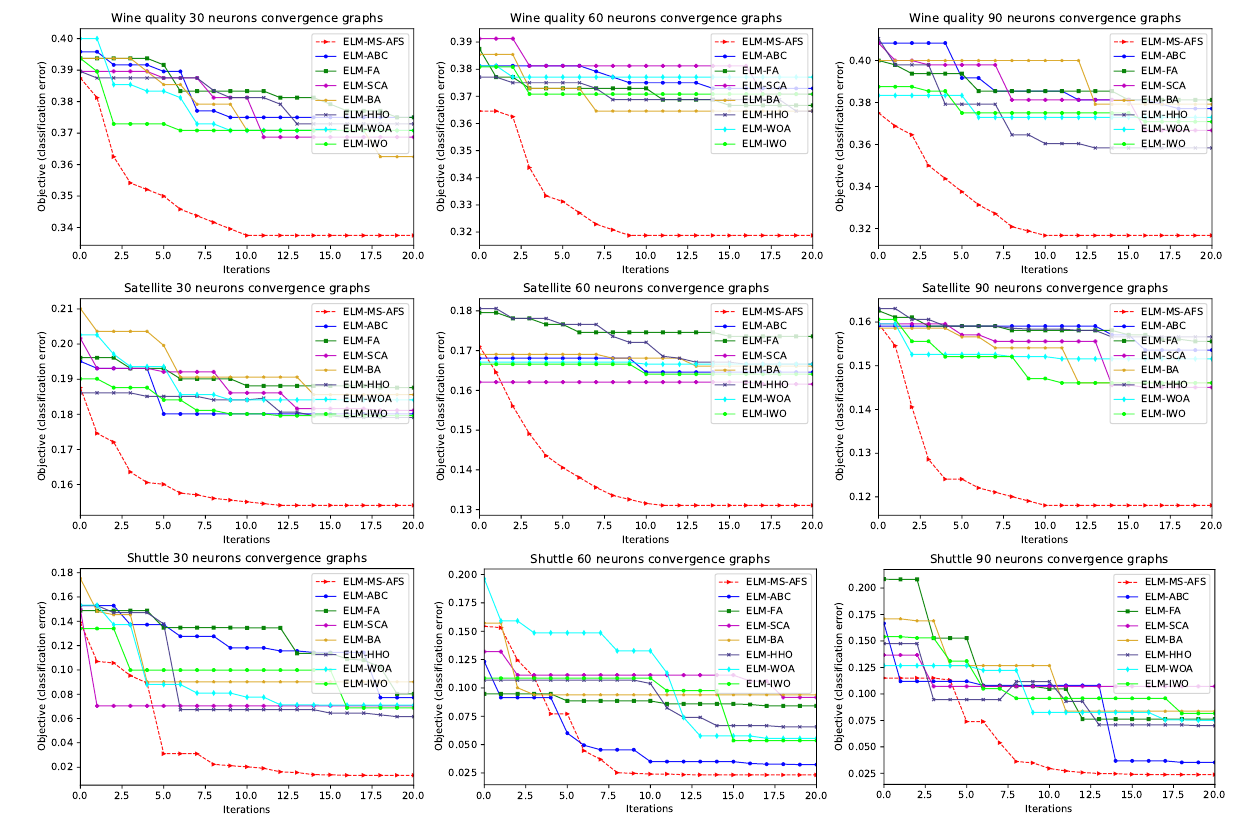
Figure 4. Graphs for convergence speed evaluation on seven observed datasets for 30, 60, and 90 neurons, for the proposed method vs. other approaches. Table 5. Precision, recall, and f1-score comparative analysis for simulations with 30